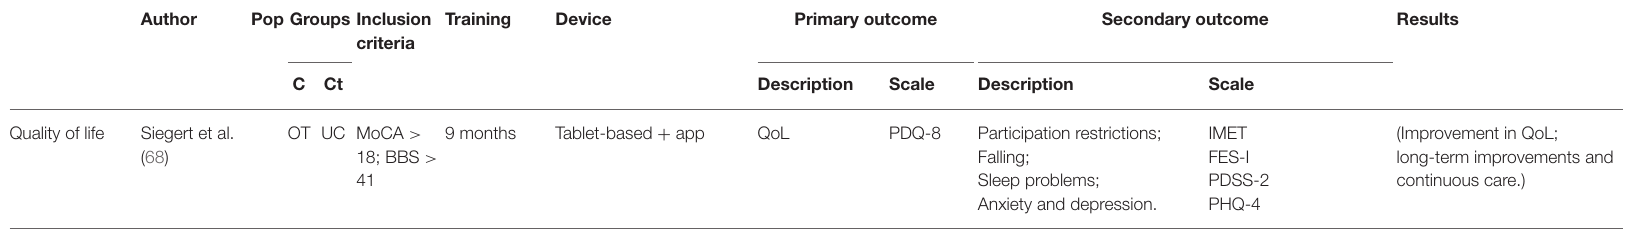
TABLE 8 | Description of the article included which have “Quality of Life” as primary outcome.